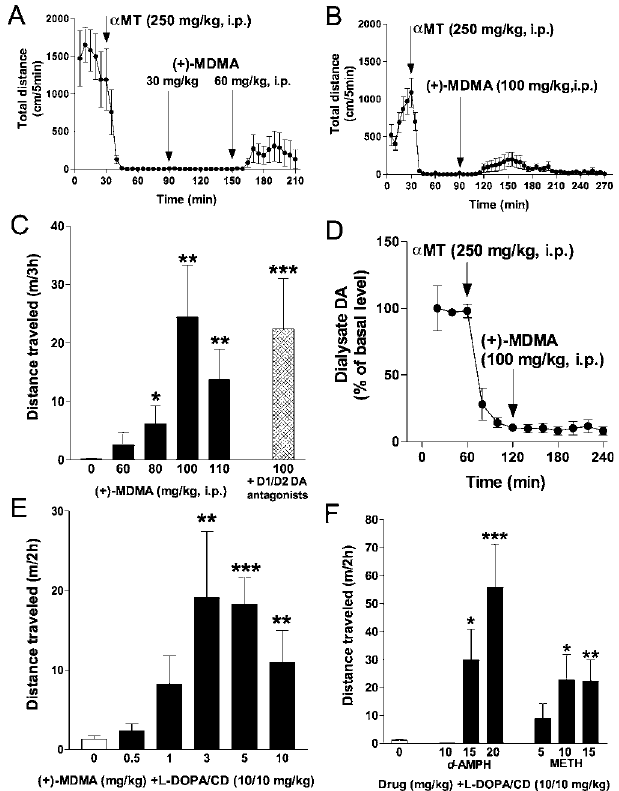
Figure 6. ( þ )-MDMA Induces Forward Locomotion in DDD Mice (A–C) DAT-KO mice were placed in the locomotor activity chamber and 30 min later were treated with a MT (250 mg/kg IP) and 1 h after a MT were challenged with single (B and C) or multiple doses (A) of a drug (interval between treatments is 1 h) ( n ¼ 10–16 per group). Repeated treatment with ( þ )-MDMA (30 and 60 mg/kg IP) induces forward locomotion in DDD mice (A). Analysis of total distance traveled for 1 h after 60 mg/kg IP of ( þ )-MDMA reveals significant effect of treatment versus respective period in saline-treated controls (p , 0.05, two-tailed Mann-Whitney U test, data not shown). Dynamics (B) and dose-response (C) of locomotor effect of ( þ )-MDMA in DDD mice are shown. Pretreatment with D1 and D2 DA antagonists (SCH23390, 0.1 mg/kg SC plus raclopride, 2 mg/kg IP) 30 min before 100 mg/kg IP ( þ )-MDMA) did not affect locomotor action of ( þ )-MDMA (C). (D) ( þ )-MDMA (100 mg/kg IP) fails to affect DA dynamics in the striatum of DDD mice as measured by in vivo microdialysis. Data are presented as a percentage of the average level of DA measured in at least three samples collected before a MT administration ( n ¼ 4). Analysis of area under curve values for 120-min periods after ( þ )-MDMA administration revealed no significant difference in comparison with respective values in control group (Figure 1F; p . 0.05, two-tailed Mann-Whitney U test). (E and F) ( þ )-MDMA (E) as well as d -amphetamine and d -methamphet- amine (F) at moderate doses potentiate locomotor-stimulating effect of subthreshold dose of L-DOPA/carbidopa (10/10 mg/kg IP). DAT-KO mice were treated with a MT as described above (A–C) and 45 min after a MT were injected with amphetamines. L-DOPA/carbidopa was injected 15 min after amphetamines, and distance traveled for 2h was measured ( n ¼ 6–15 per group). Note, that no forward locomotion was observed after these doses of ( þ )-MDMA, d -amphetamine and d -methamphetamine without L-DOPA/carbidopa, whereas L-DOPA/carbidopa (presented as drug dose 0) induced only a modest but significant ( p , 0.05) increase in locomotion over saline-treated controls (data not shown). Single asterisk indicates p , 0.05; double asterisks indicate p , 0.01; and triple asterisks indicate p , 0.001 versus saline-treated controls (C) or L-DOPA/carbidopa-treated (10/10 mg/kg IP) group (E and F) (two- tailed Mann-Whitney U test). d -AMPH, d -amphetamine; METH, d